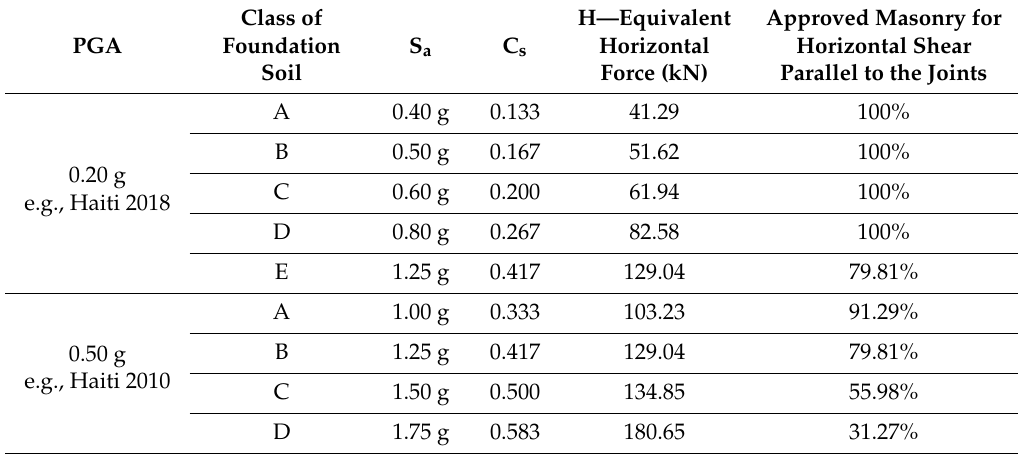
Table 13. Seismic scenarios and the evaluation for horizontal shear e ff orts, parallel to the joints. Adapted from